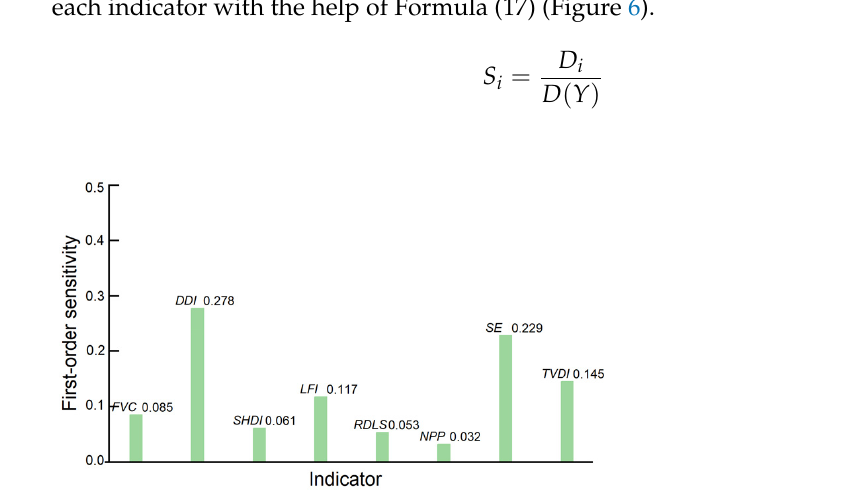
Figure 6. First − order sensitivity of indicators for integrated assessment of ecological restoration in the Wuliangsuhai watershed.